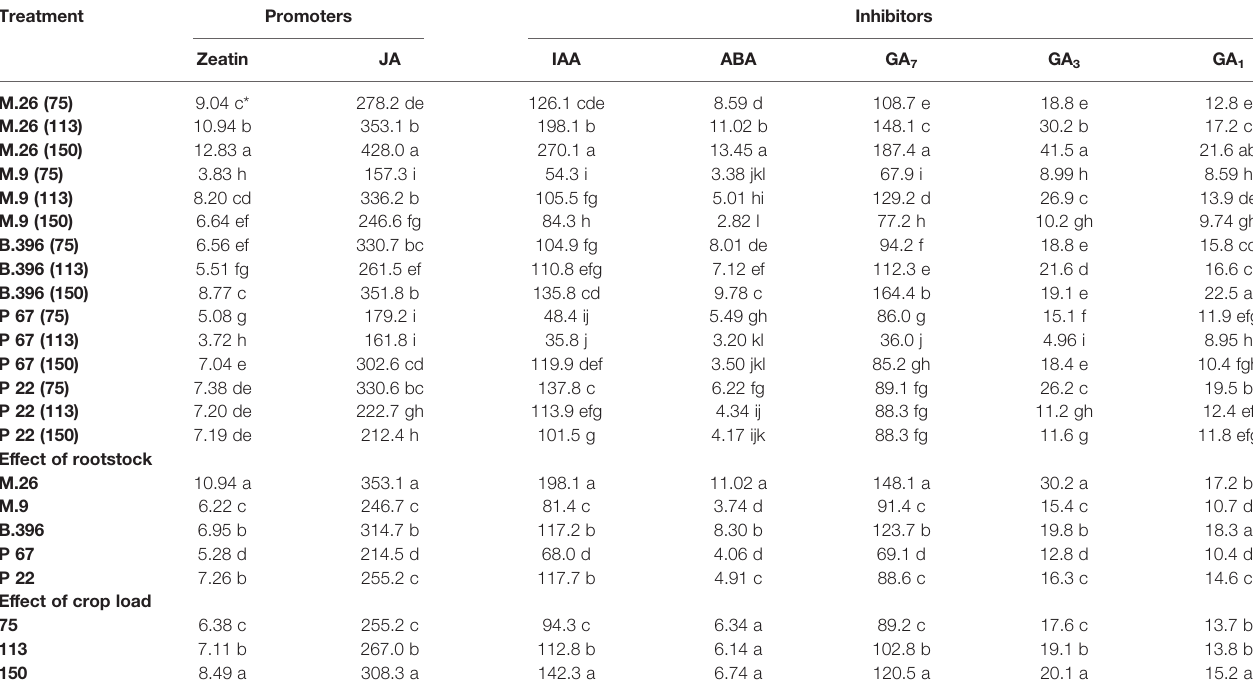
TABLE 3 | The effect of rootstock and crop load interaction on the accumulation of phytohormones in “ Ligol ” buds (ng g − 1 , FW). Treatment